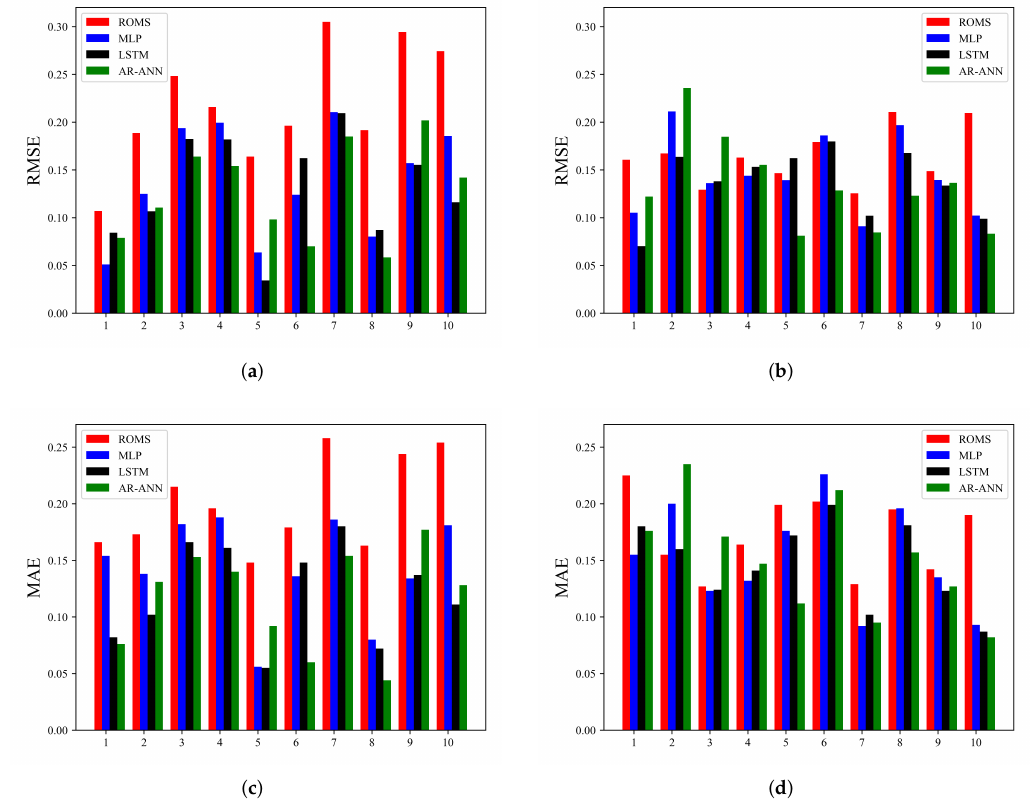
Figure 7. The evaluation metrics of the simulation and the three networks for the ten samples. ( a ) RMSE of simulation and corrected data for component u ; ( b ) RMSE of simulation and corrected data for component v ; ( c ) MAE of simulation and corrected data for component u ; ( d ) MAE of simulation and corrected data for component v